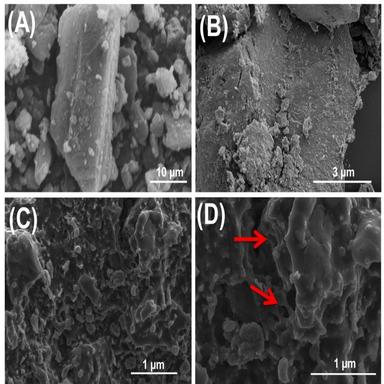
Shows the SEM images of raw coal (A), the sulfonated coal products by H2SO4 (B), high magnification image for the topography of the sulfonated coal (C), and high magnification view for the detected pores with the surface of sulfonated coal (D).